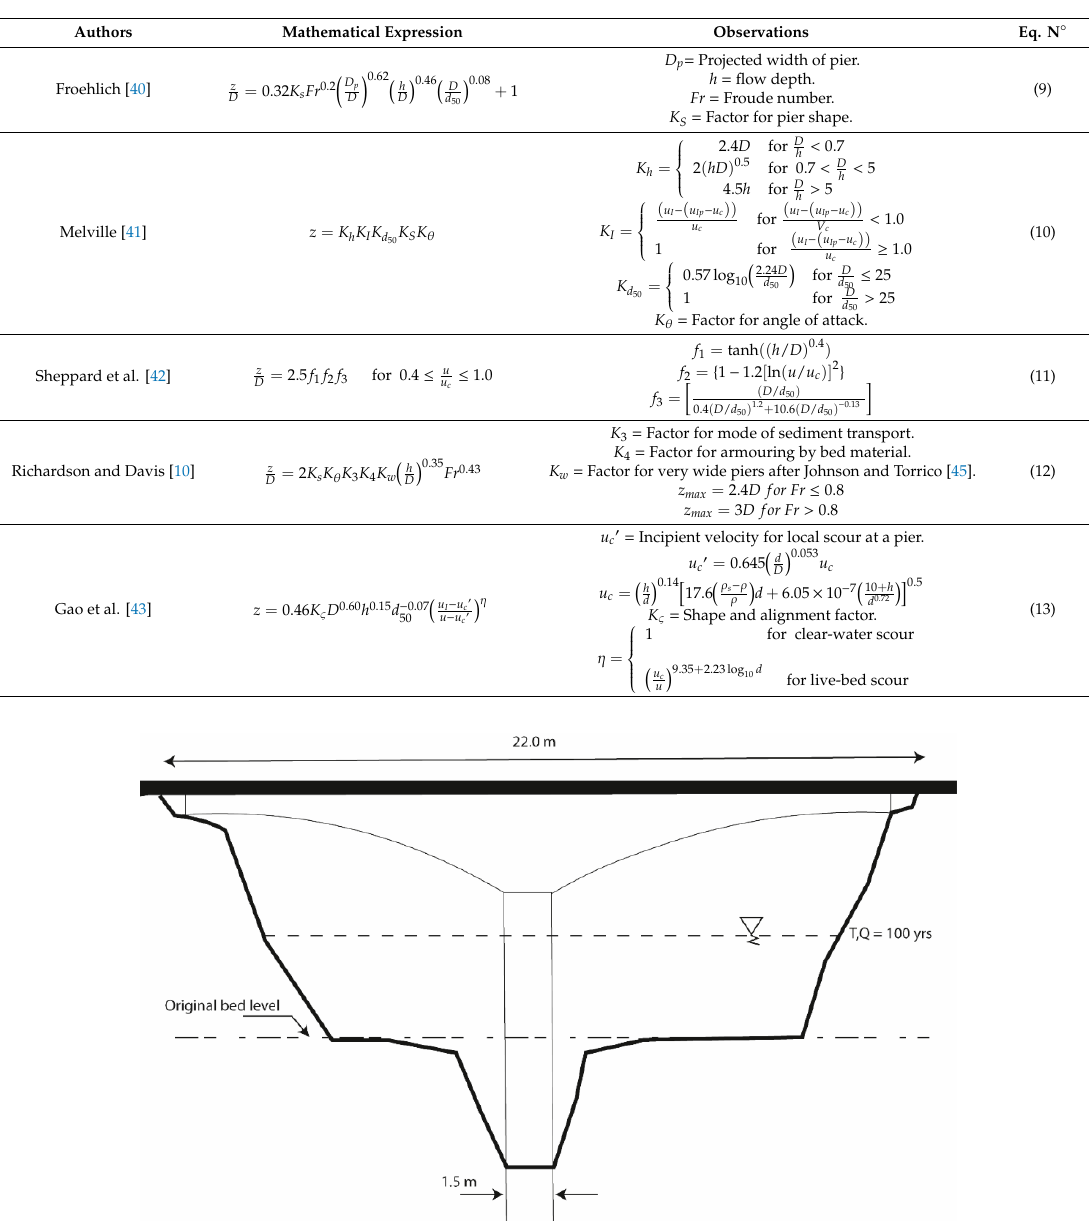
Table 2. Equilibrium-scour prediction formulas considered for benchmarking analyses.